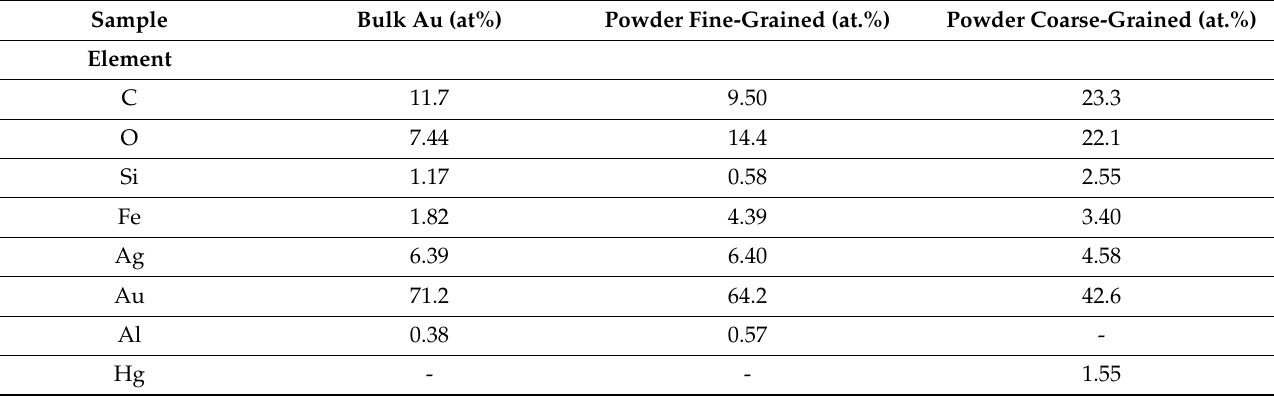
Table 3. Elements identified in the EDX analysis of bulk Au and Au powder (fine-grained and coarse-grained) concentrate samples. Sample Bulk Au (at%) Powder Fine-Grained (at.%) Powder Coarse-Grained (at.%)